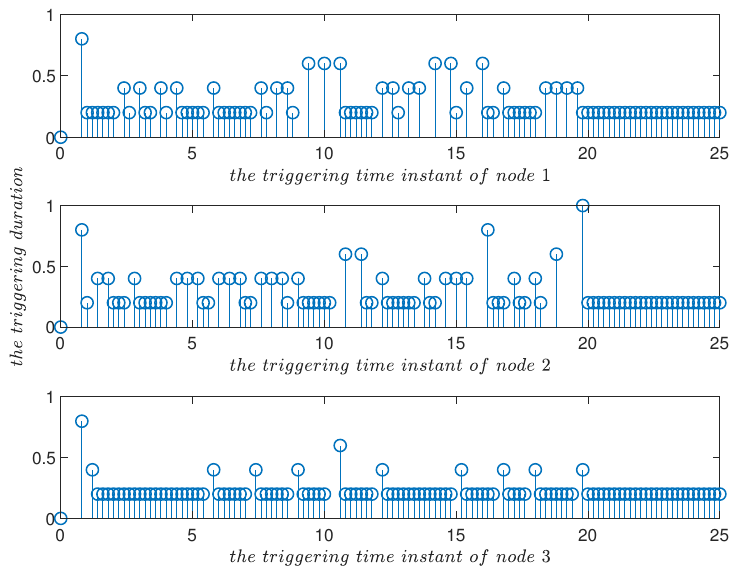
Figure 10. Triggering time instants and their duration in the improved event-triggered scheme for (cid:101) 2 ( t ) = 2 in Example 1. Compared with Figure 9, triggering parameter (cid:101) 2 ( t ) played a role in adjusting the triggering frequency.